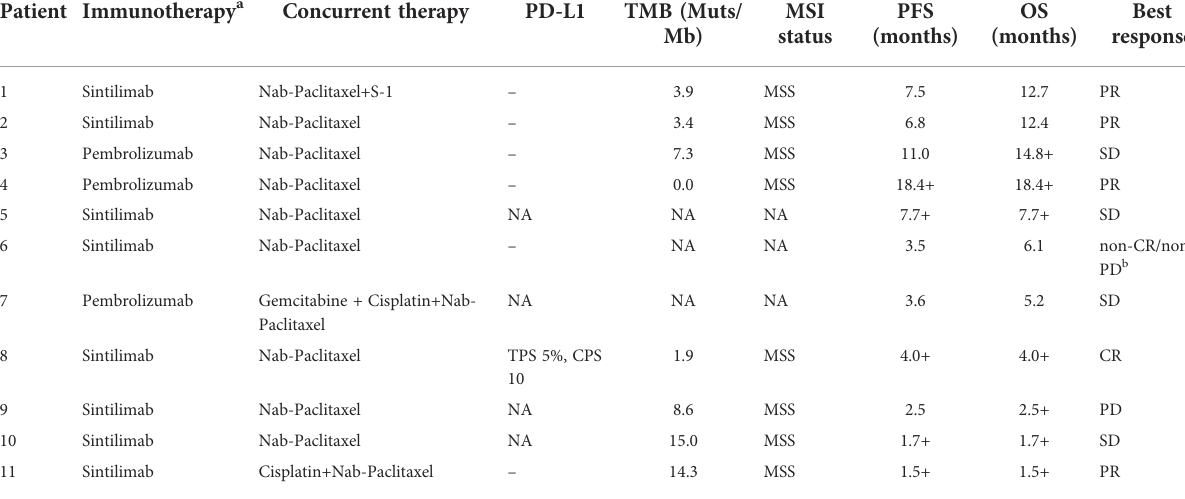
TABLE 2 Summary of the therapeutic strategies, NGS results, PD-L1 expression and clinical